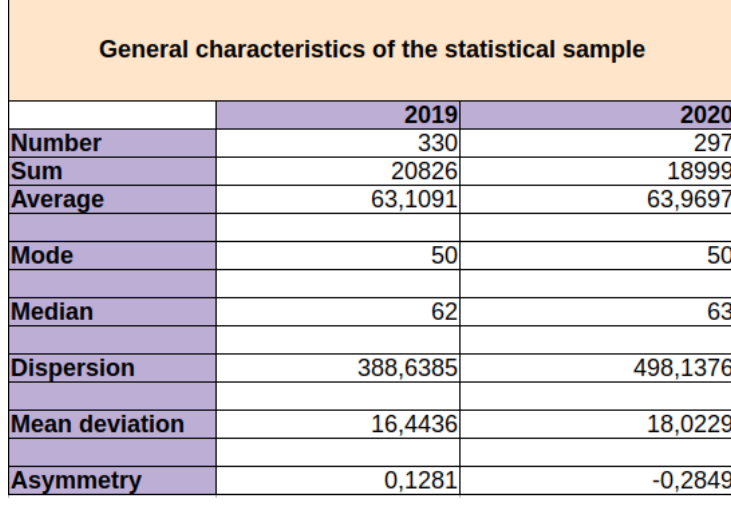
Figure 88: Presentation of paper